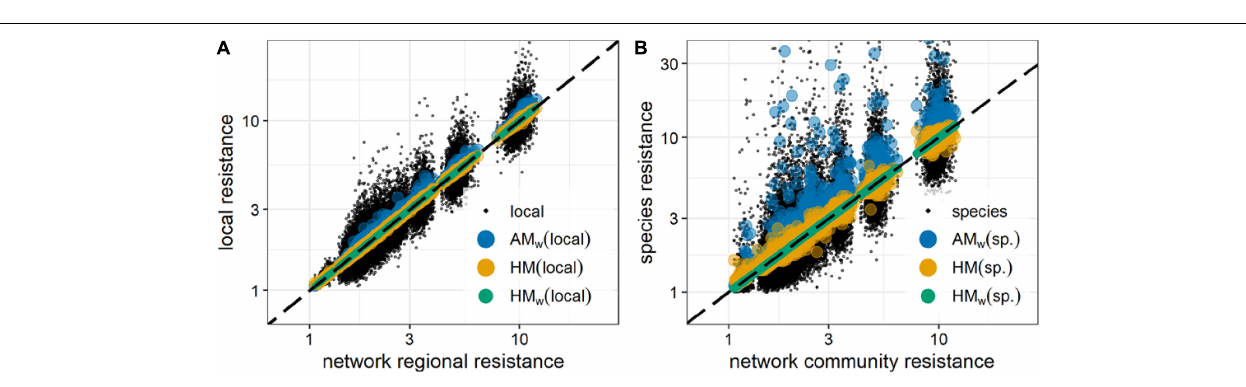
FIGURE 4 | Regional (A) and community (B) resistances, compared to local and species resistances and to their biomass weighted arithmetic mean (AM w ) (blue circles), unweighted harmonic mean (HM) (yellow circles), and biomass weighted harmonic mean (HM w ) (green circles). AM w , HM, and HM w values closer to the identity line (black, dashed) estimate more precisely the regional (A) and community resistance (B) . Black dots are the resistances of the individual localities (A) or species (B) on which the means were computed. Data were generated for 6,300 random communities of 10 competitors in 10-node random spatial networks ( Supplementary Figure 1A and Supplementary Text ), from the biomass decrease caused by a reduction of the species growth rates at all locations. The harmonic mean of resistances is always smaller than the arithmetic mean (see Supplementary Appendix C ). Moreover, HM w are found to be better estimators for the resistance, as expected from the results shown in the